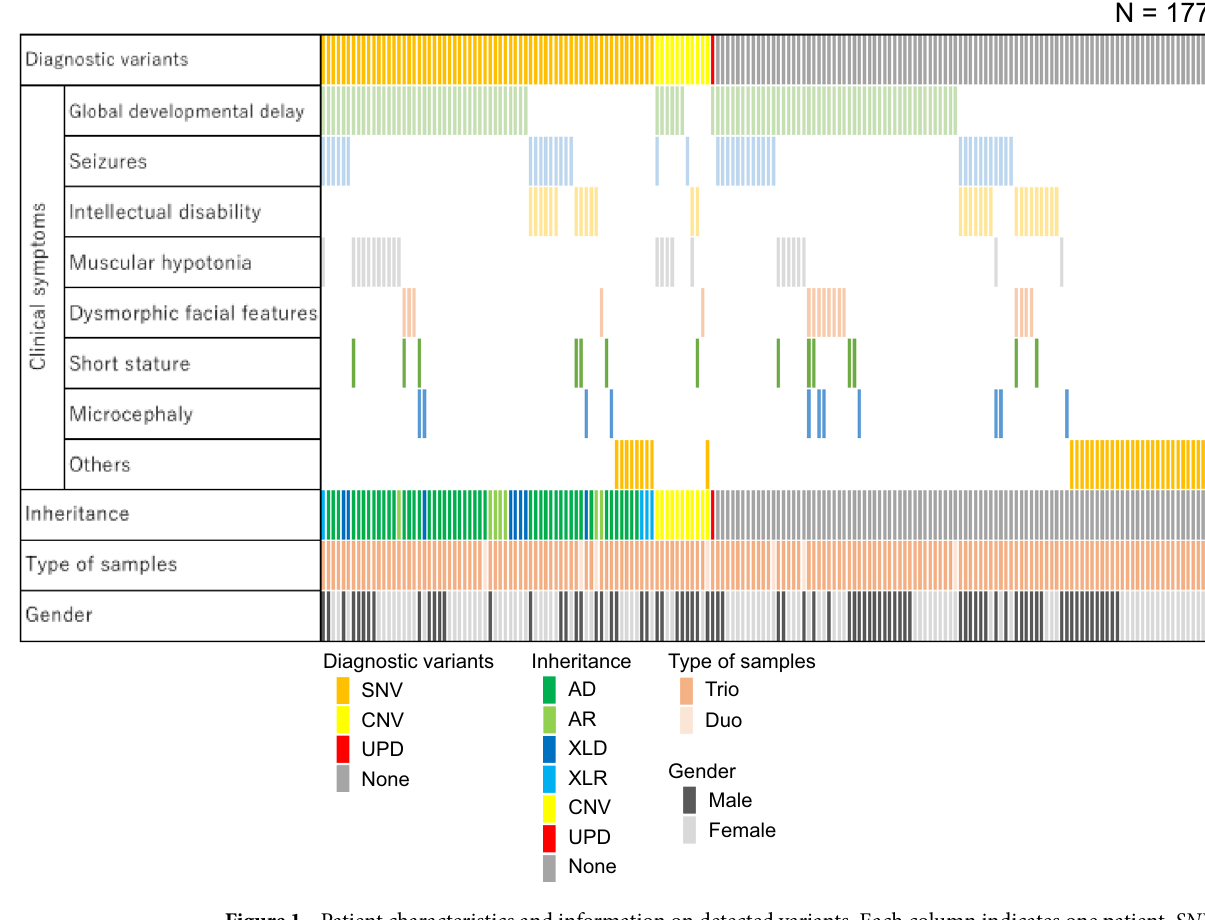
Figure 1. Patient characteristics and information on detected variants. Each column indicates one patient. SNV single-nucleotide variant, CNV copy number variant, UPD uniparental disomy, AD autosomal dominant, AR autosomal recessive, XLD X-linked dominant, XLR X-linked